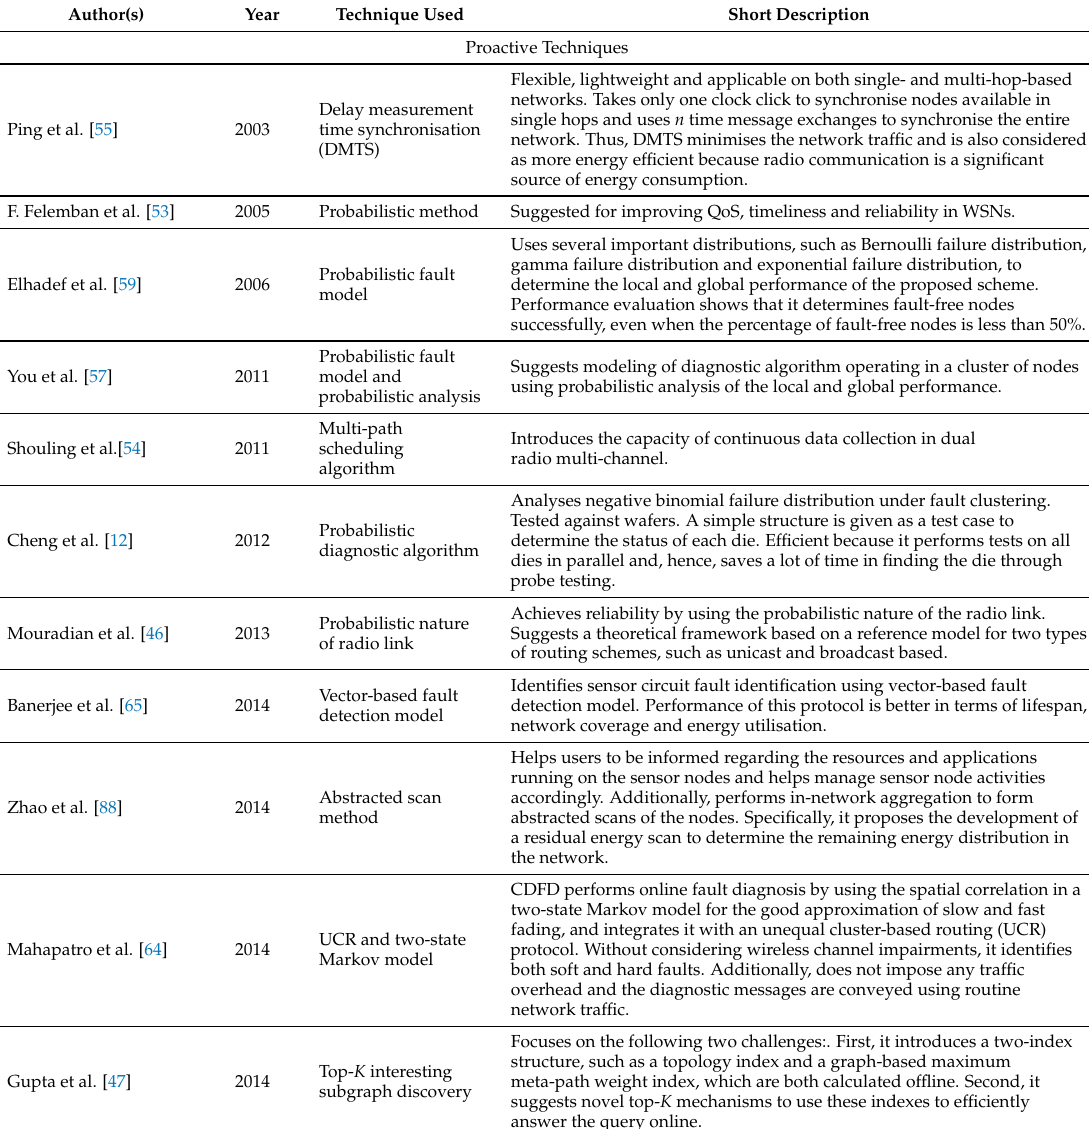
Table 1. Overview of Fault Diagnosis